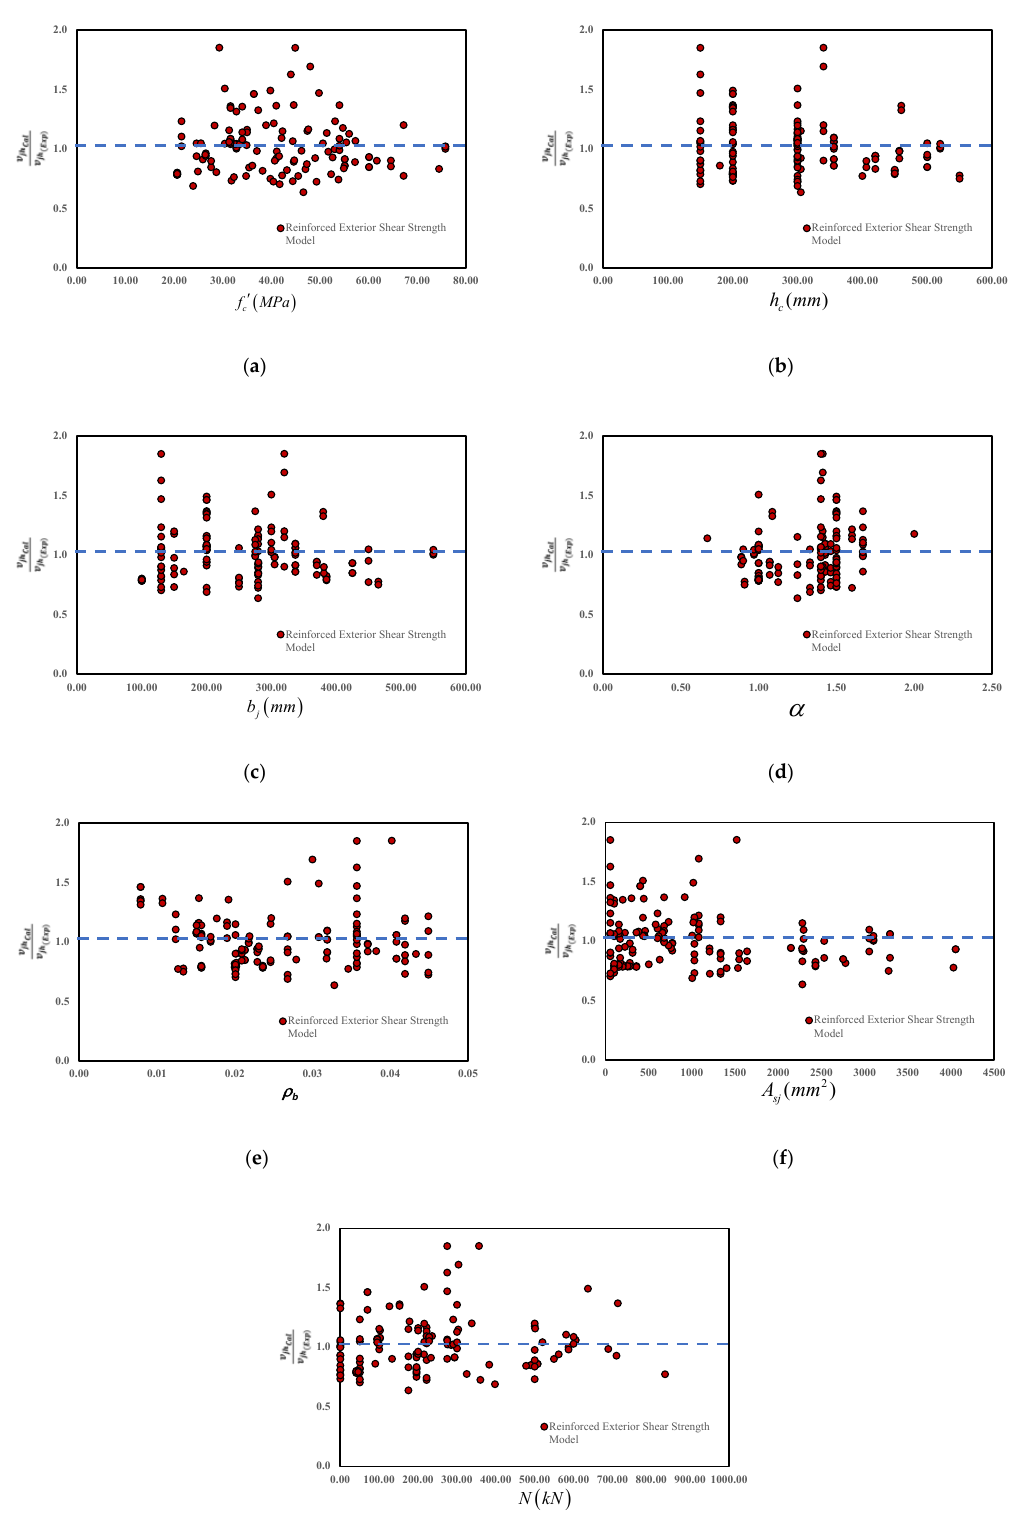
Figure 7. The predictive performance of the proposed unreinforced joint shear strength model based on the main parameters. ( a ) Concrete compressive Strength ( b ) Column Depth ( c ) Joint Width ( d ) Joint aspect ratio ( e ) Beam longitudinal reinforcement ratio ( f ) Joint Axial Load.